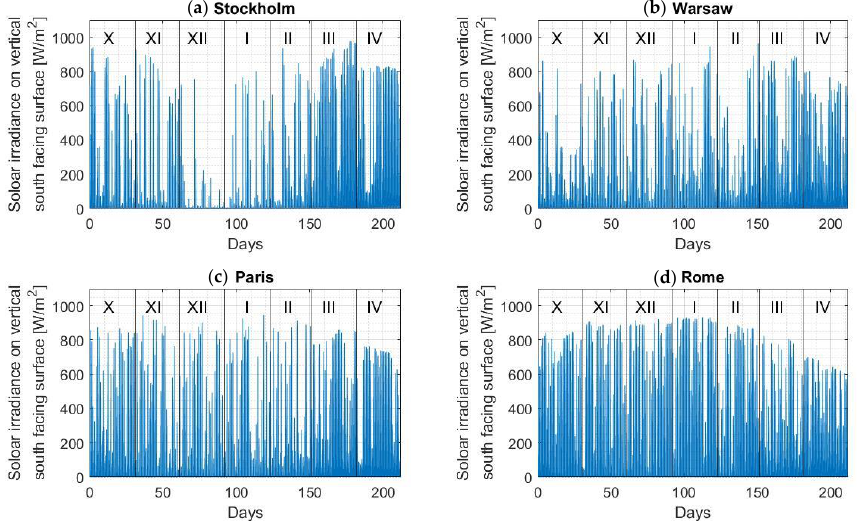
Figure 6. Solar irradiance on a vertical south facing flat surface during the heating period (on the basis of data from [44]).